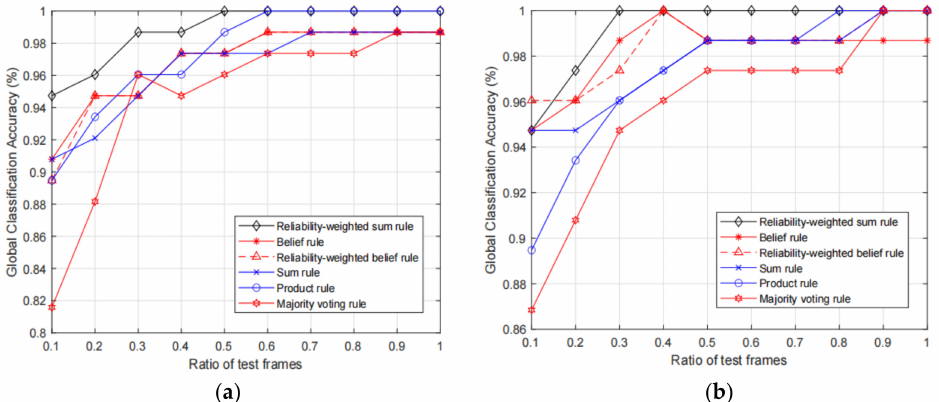
Figure 4. Comparison of fusion accuracies with 10 optical motion trackers, in which ( a ) and ( b ) show the results with original input features and calibrated input features, respectively.